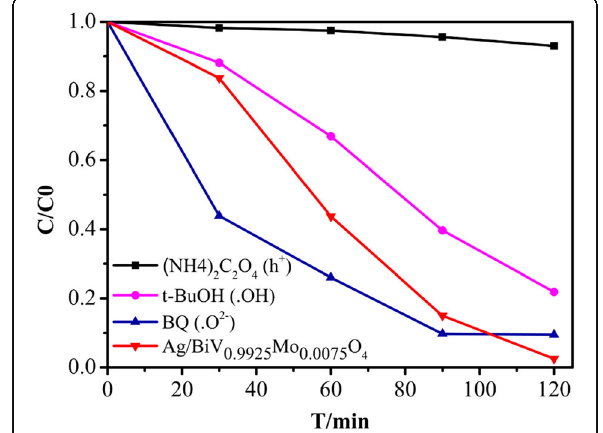
Fig. 11 Plots of photogenerated carrier trapping in the system during the photodegradation of RhB by Ag/BiV 0.9925 Mo 0.0075 O